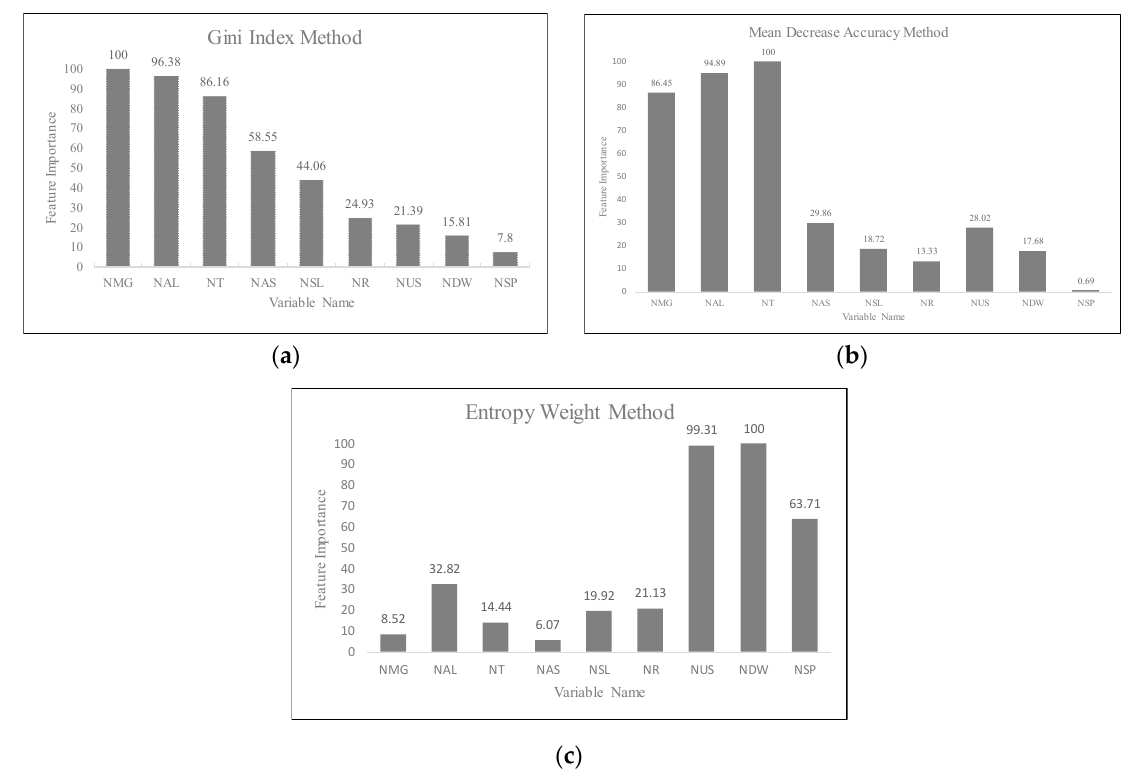
Figure 6. Variable weight relation graph. ( a ) Gini index method; ( b ) Mean decrease accuracy method; and ( c ) Entropy weight method.